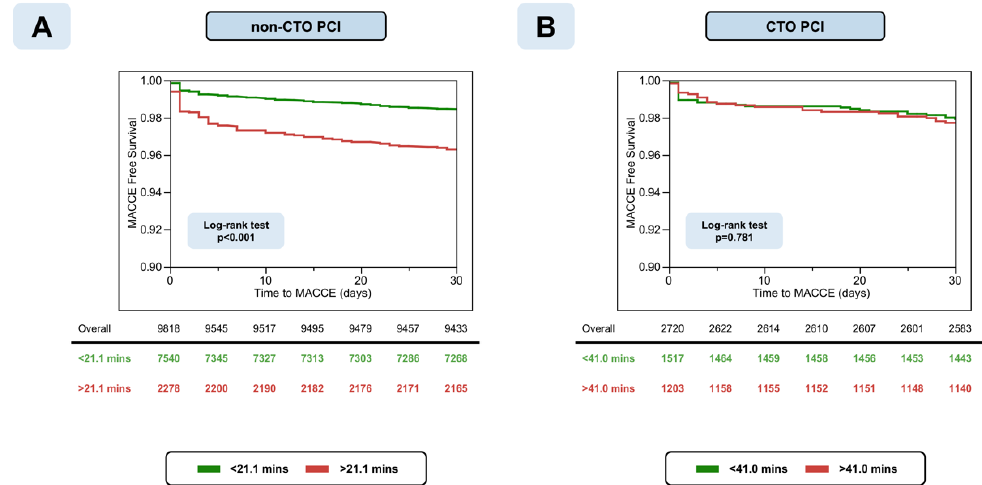
Figure 4. Kaplan – Meier curves of 30-days major adverse cardiac and cerebrovascular events Figure 4. Kaplan–Meier curves of 30-days major adverse cardiac and cerebrovascular events (MACCE) in patients undergoing (MACCE) in patients undergoing prolonged non-occlusive (non-CTO, Panel A) and chronic occlu- prolonged non-occlusive (non-CTO, Panel A ) and chronic occlusive (CTO, Panel B ) percutaneous coronary interventions (PCI). sive (CTO, Panel B) percutaneous coronary interventions (PCI). The odds ratios (OR) of procedural failure for a 10-min increment in FT were 1.05